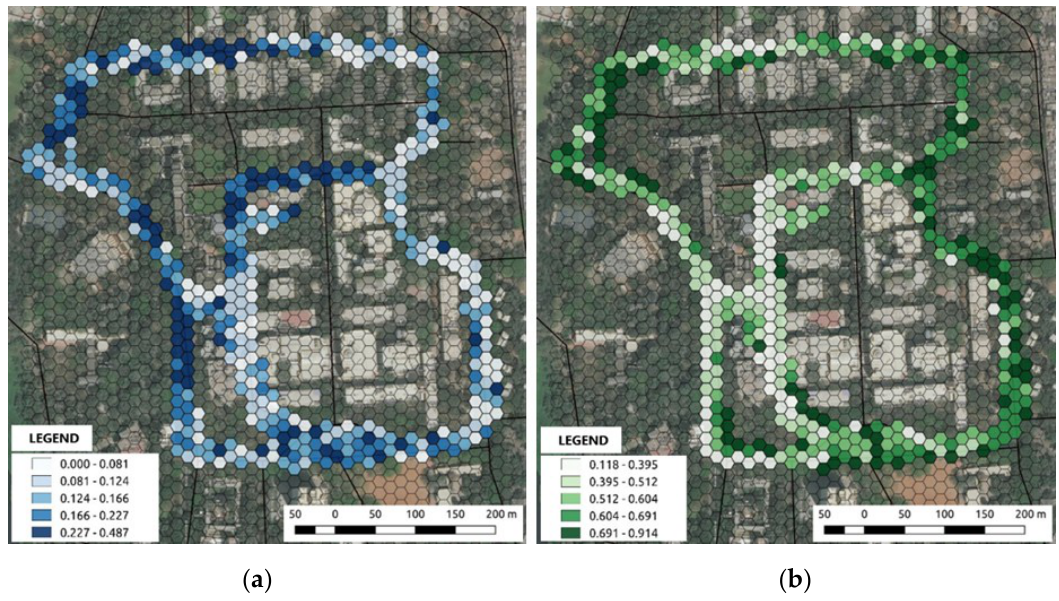
Figure 6. Maps showing sky view ( a ) and green cover ( b ) percentages. Note: The legend in ( a ) explains the percentage of sky view (Very low: 0.00–0.081, low: 0.081–0.124, medium: 0.124–0.166, high: 0.166–0.227, very high: 0.227–0.487); similarly the legend in ( b ) explains the percentage of green cover (Very low: 0.118–0.395, low: 0.395–0.512, medium: 0.512–0.604, high: 0.604–0.691, very high: 0.691–0.914).